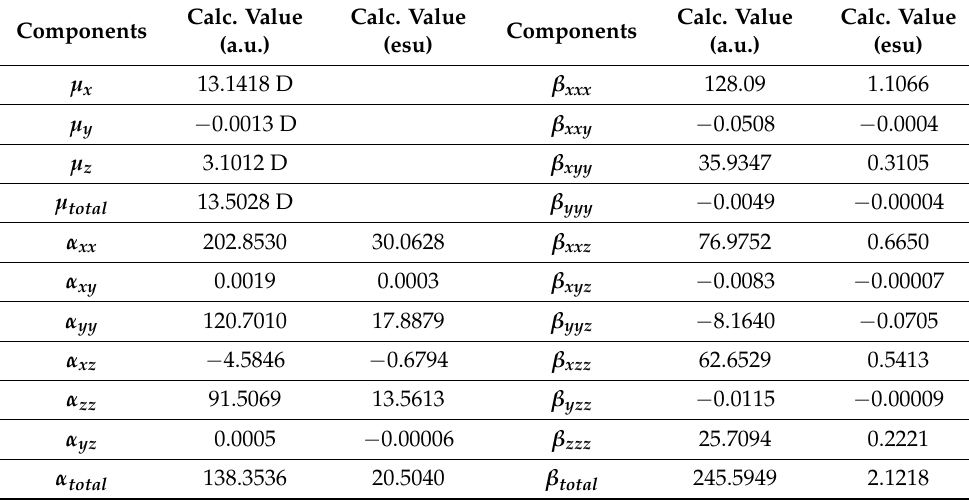
Table 5. The calculated (Calc.) values of dipole moment (debye), polarizability ( α × 10 − 24 esu)